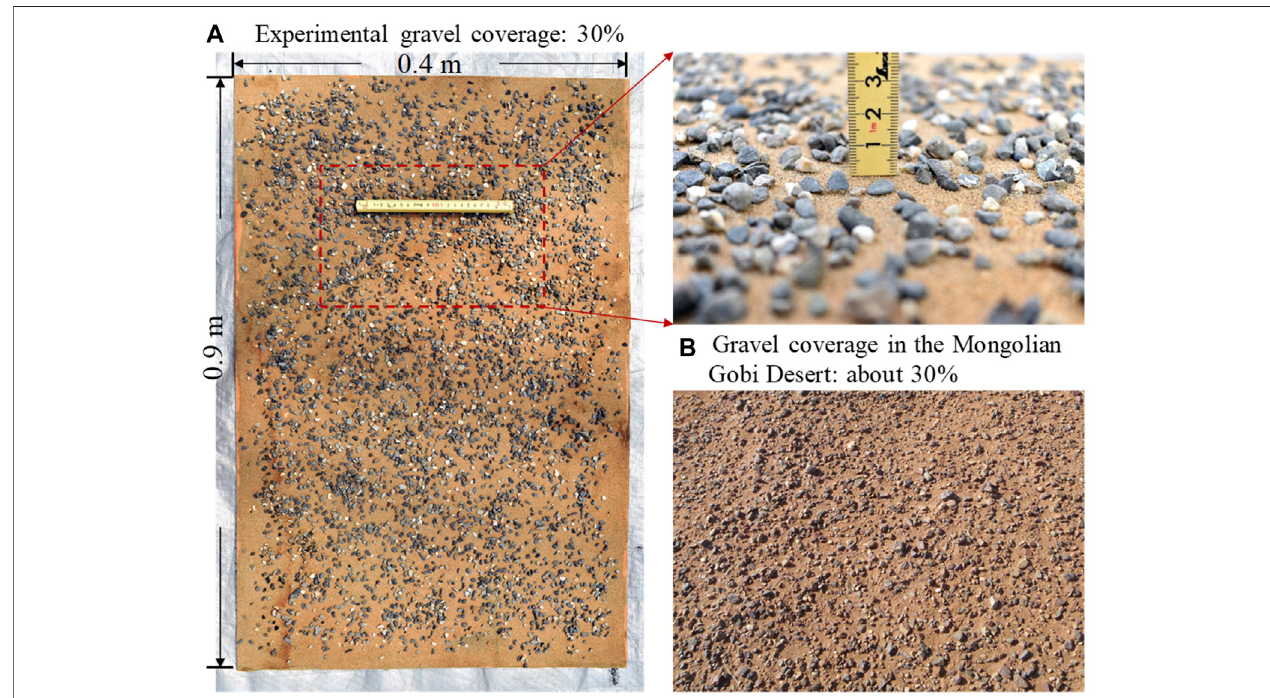
FIGURE 4 | Photographs for comparison of gravel size and coverage of 30% (A) in our wind-tunnel experiments and (B) in the Mongolian Gobi Desert (Liu et al., 2020).